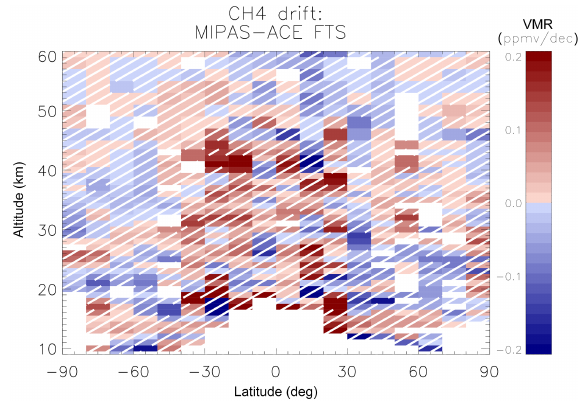
Figure 7. Drifts of MIPAS with respect to ACE-FTS methane mea- surements as a function of height and latitude. The bins where the significance is less than 2 σ are